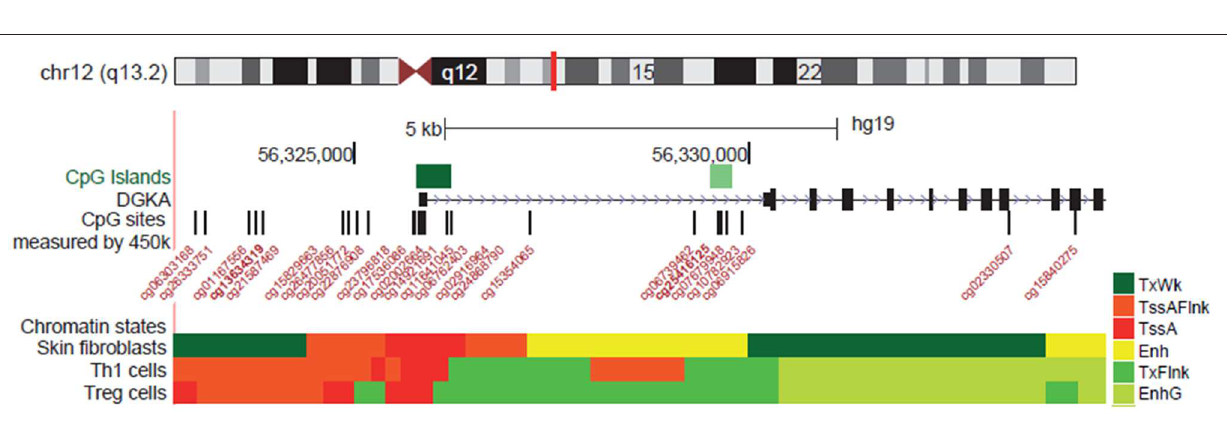
FIGURE 3 | Regulation of DGKA expression by DNA methylation. Location of DGKA on chromosome 12 and transcriptional regulation as shown in the UCSC Browser, hg19 assembly [http://genome.ucsc.edu/; (53)]. Regulatory elements are indicated by CpG islands and chromatin states (Encode ChromHMM) characterizing transcription start site (TssA, TssAFlnk, TXFlnk) and enhancer (Enh) in human skin fibroblasts (54). CpG probes (Illumina 450K BeadChipArray) located in the DGKA promotor area are